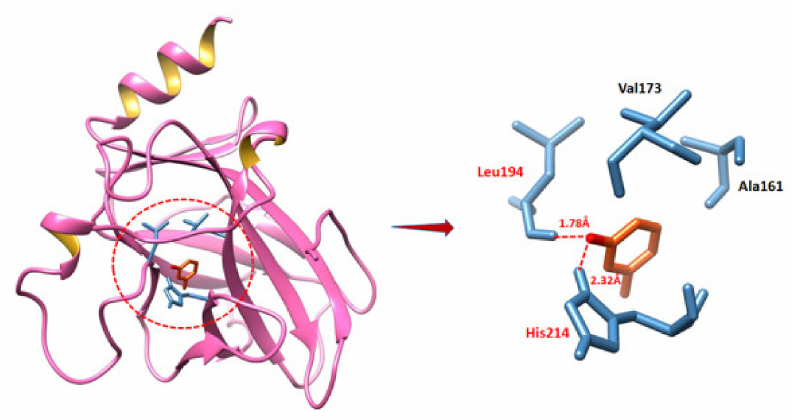
Figure 11. Binding analysis of P53 with